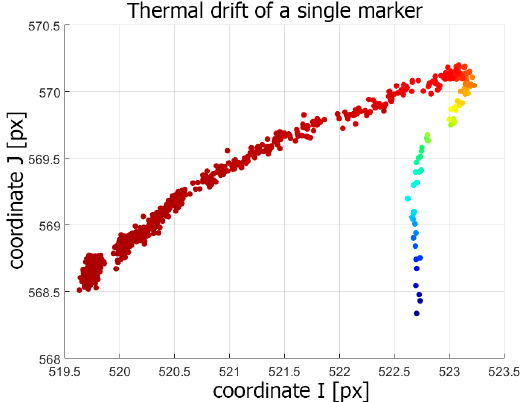
Figure 9. The trajectory of a single marker during the warming-up process of the Casio XJ-A252 projector.